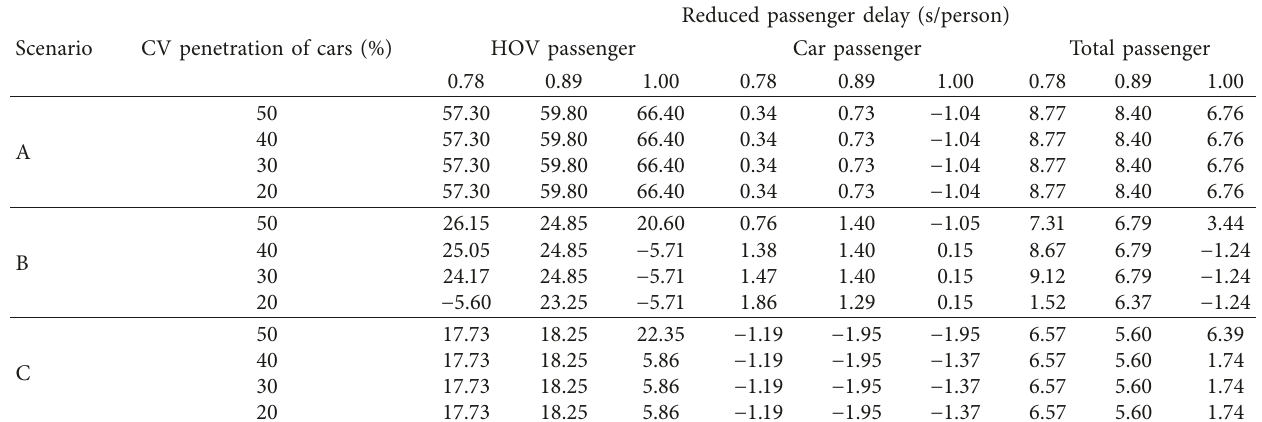
Table 4: Results of reduced passenger delay.